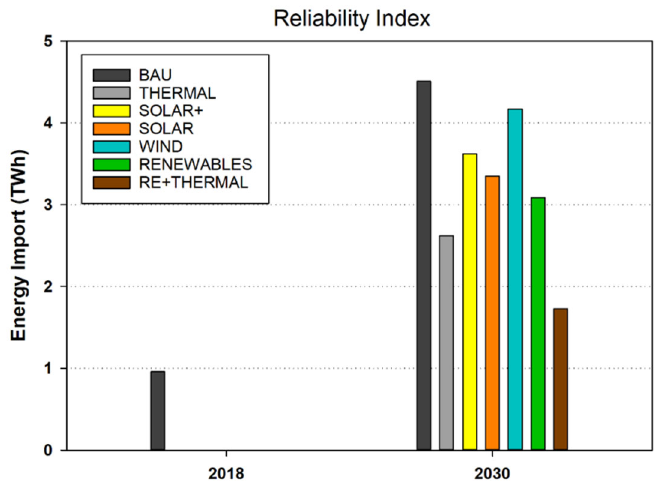
Figure 8. Energy import as reliability index for base and forecast years.